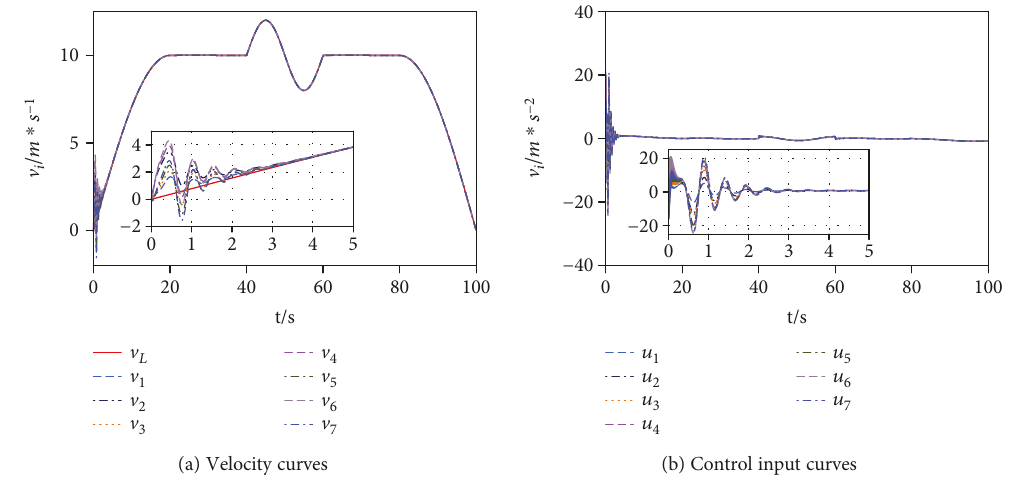
Figure 3: Vehicle platoon control without input saturation and velocity